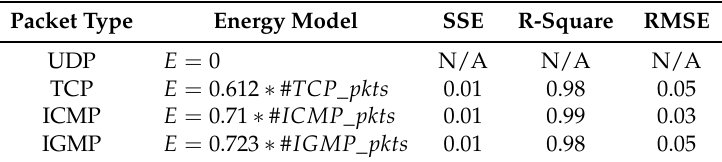
Table 4. Energy model, packet type and